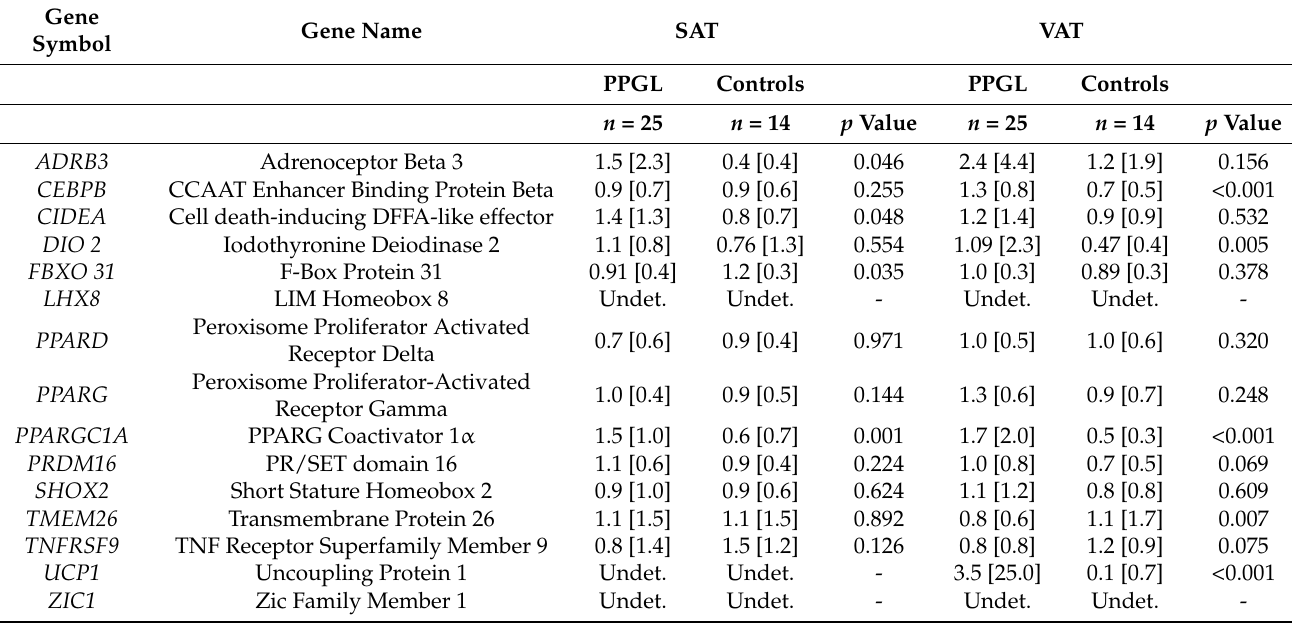
Table 2. mRNA expression of genes potentially connected with BAT and BeAT in SAT and VAT samples of patients with PPGL and controls.